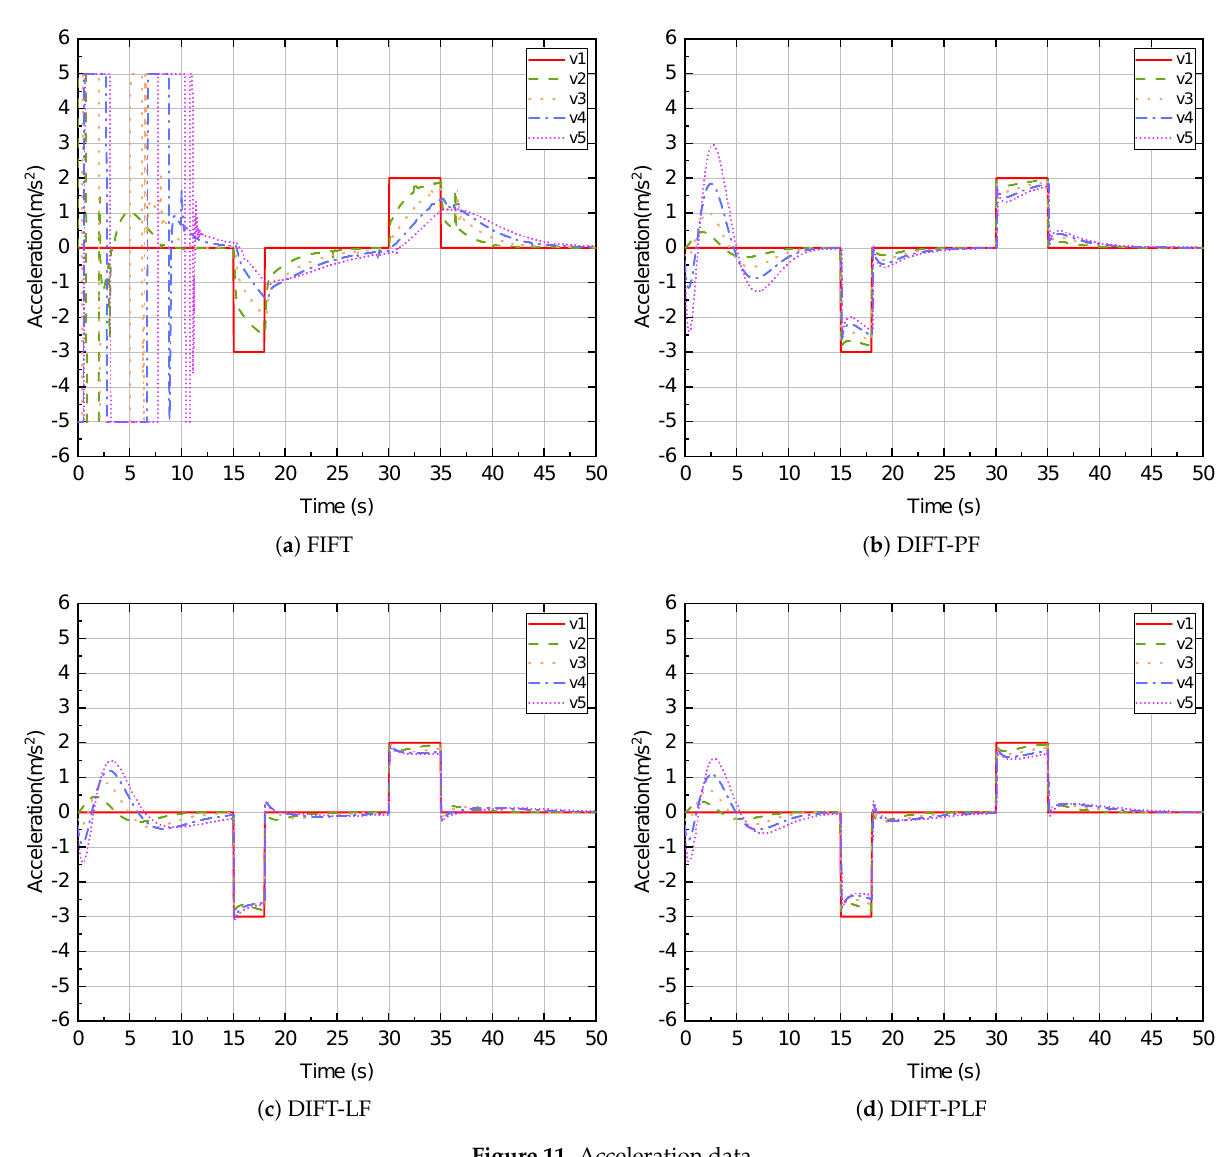
Figure 11. Acceleration data. Figure 13 shows the velocity tracking errors of FIFT in Figure 13a and DIFTs in Figure 13b–d. The velocity errors of FIFT oscillate irregularly at the start of the simulation; the system spends a lot of time obtaining relative speed with the maximum error of 6.913 m/s. In contrast, all DIFTs perform stable and convergent speed tracking with low velocity errors. To be specific, the maximum velocity error scope of DIFT-PF, DIFT-LF, DIFT- PLF is within [ − 1.472, 1.119 ] m/s, [ − 1.031, 0.697 ] m/s, [ − 0.757, 0.690 ] m/s, respectively. The mean values of velocity tracking errors of above four information topologies are 0.171 m/s, 0.031 m/s, 0.025 m/s, 0.008 m/s. Since DIFT-PLF presents great accuracy and convergence, it further demonstrates the proposed control strategy can improve the effectiveness and string stability in CAV platoon